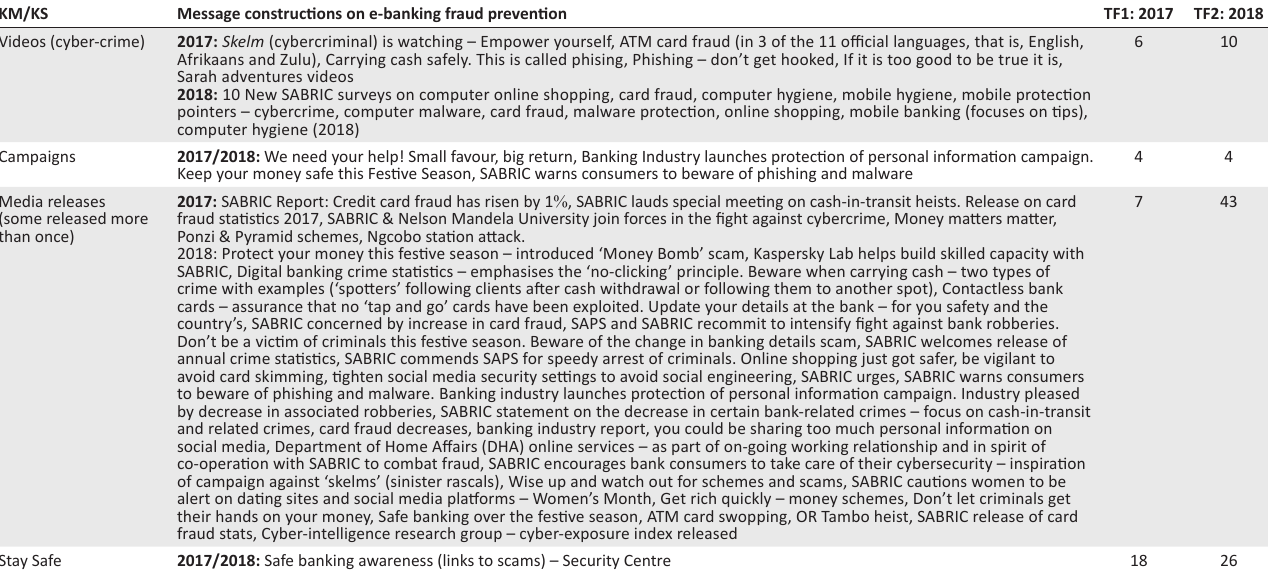
TABLE 1: Content of the website: comparison between message construction in 2017 and 2018.